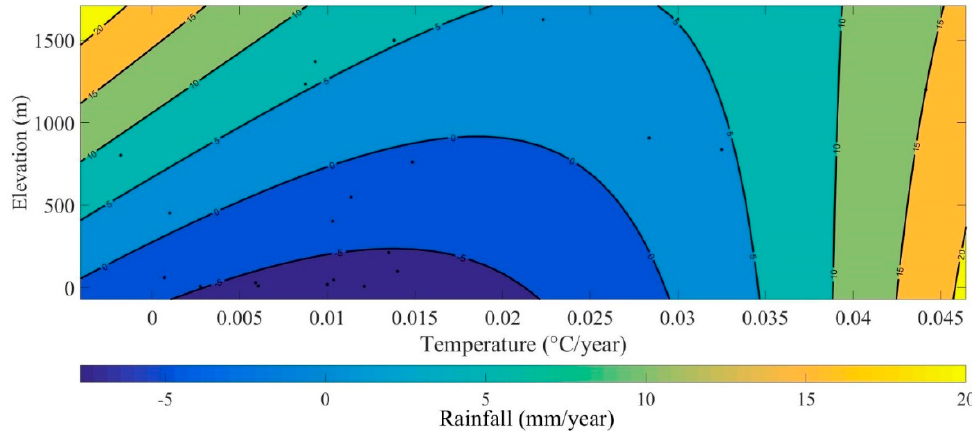
Figure 9. Contour plot of rainfall variation, temperature, and elevation.